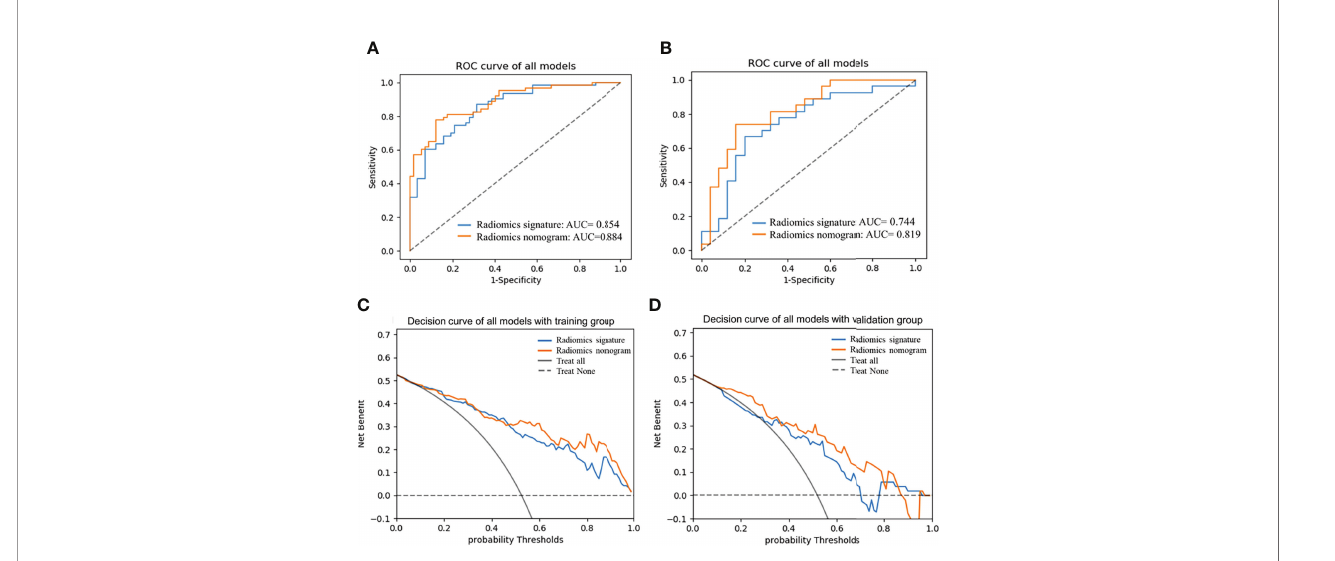
FIGURE 6 | AUCs of radiomics nomogram and radiomic signature in training (A) and validation (B) groups; Decision curve analysis curve of the nomogram in training (C) and validation groups (D) . AUC, area under the receiver operating characteristic